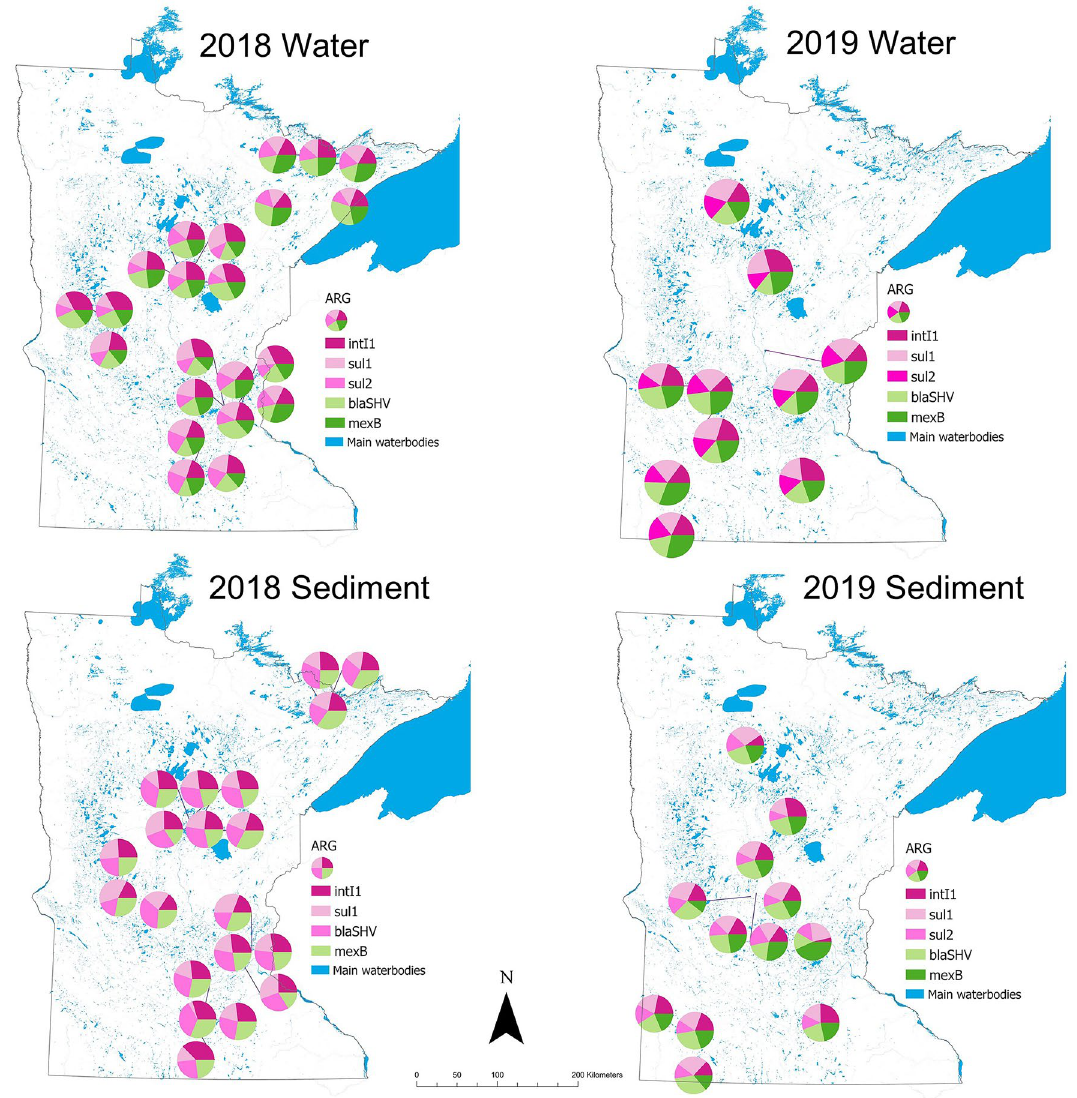
Figure 5. Antimicrobial resistance gene (ARG) abundance for main genes detected in sampling sites in 2018 (water and sediment) and 2019 (water and